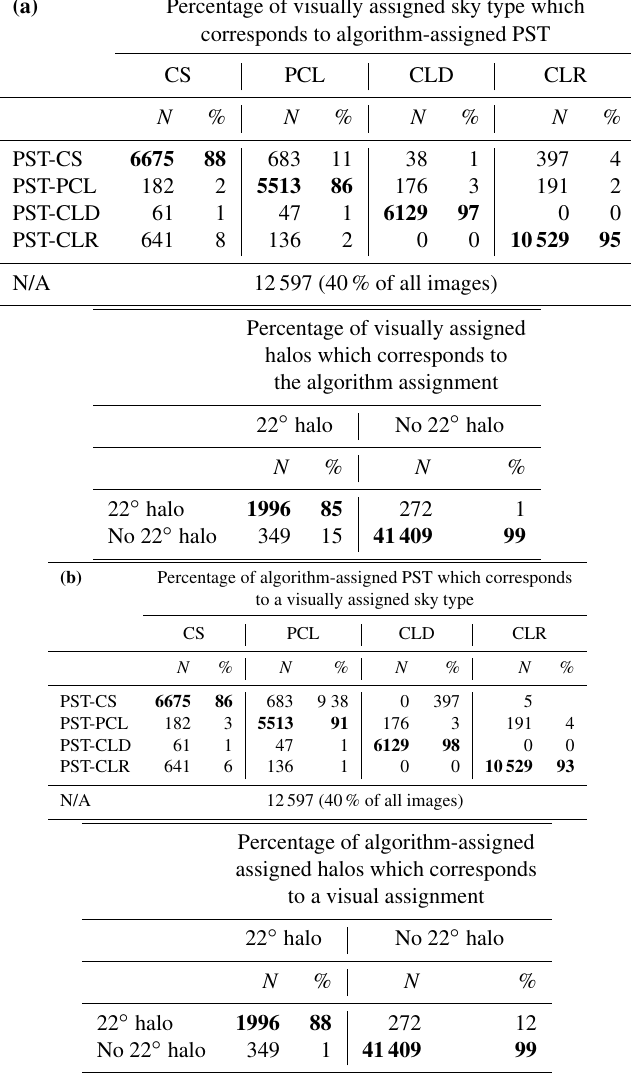
Table 5. Algorithm versus visual classifications for SGP March 2018. (a) shows the percentage of visual assignments corresponding to algorithm assignments; (b) shows the percentage of algorithm assignments and how they distribute among the visual assignments. For example, 88% of all visual CS skies are classified as PST-CS by the algorithm, but only 86% of all algorithm PST-CS skies also identify as visual CS. Agreement combinations are shown in bold. A halo was assigned to an image if